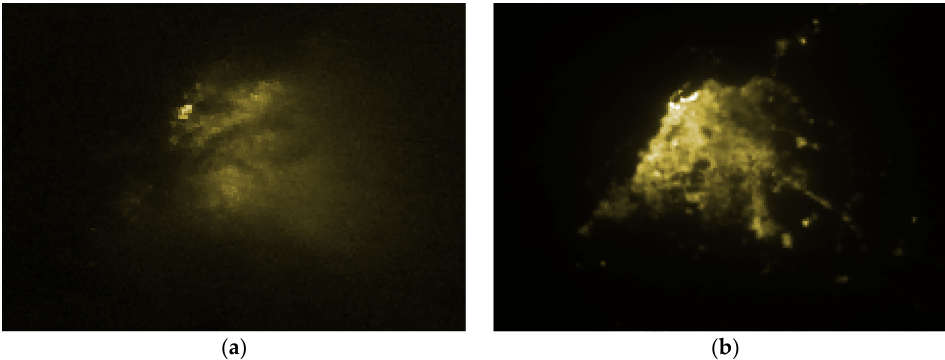
Figure 2. ( a ) Luanda city area in Angola is seen in unprocessed VIIRS night-time data acquired on 16 April 2020; ( b ) the image shows the same location in the processed VIIRS night-time data corrected for moon illumination and bad pixels using quality flags and then compositing for the entirety of April 2020.